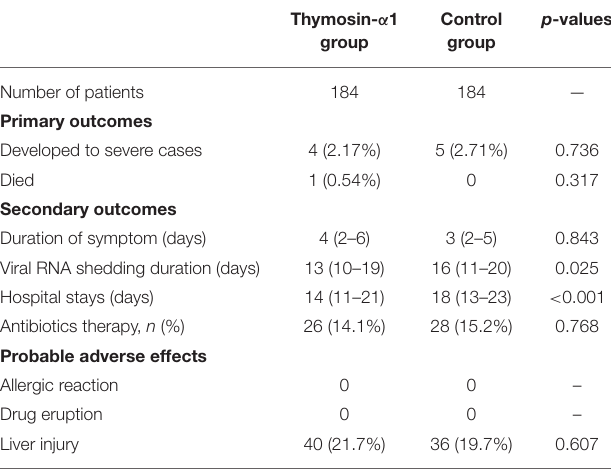
TABLE 4 | Evaluation of efficacy for Thymosin- α 1 in propensity-matched groups. Thymosin- α 1